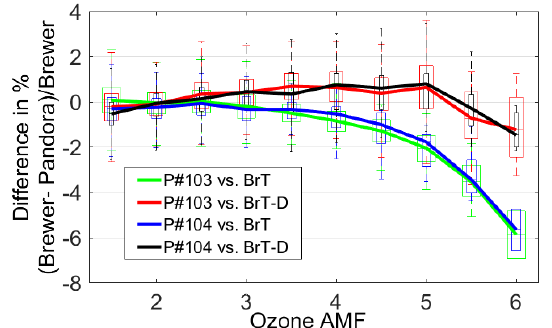
Figure 15. Percentage difference between Pandoras (nos. 103 and 104) and Brewers (grouped as BrT and BrT-D) as a function of ozone air mass factor. On each box, the central mark is the me- dian, the edges of the box are the 25th and 75th percentiles, and the whiskers extend to the most extreme data points not considered